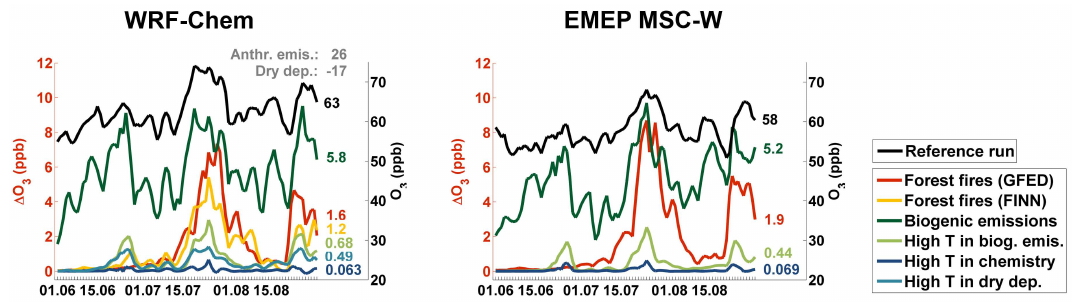
Fig. 9. Daily maximum surface ozone in the reference run (ppbv; right y-axis) and the differences between the reference run and the sensitivity runs showing the impact of various processes on daily maximum surface ozone (ppbv, left y-axis), averaged over the EM region, calculated by the WRF-Chem (left) and EMEP (right) models. Seasonally averaged values are shown next to the